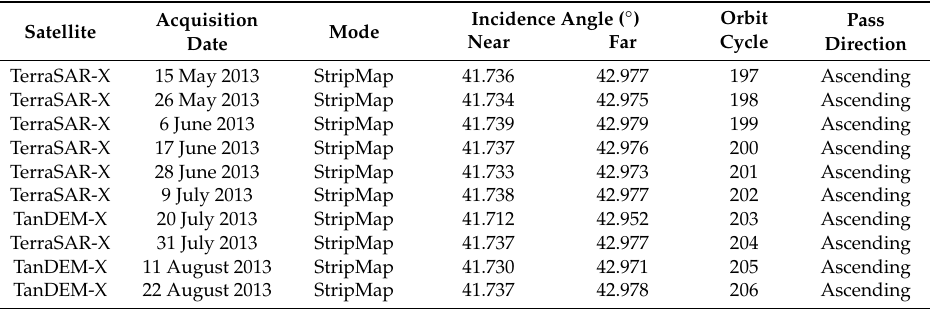
Table 2. Characteristics of the satellite data.